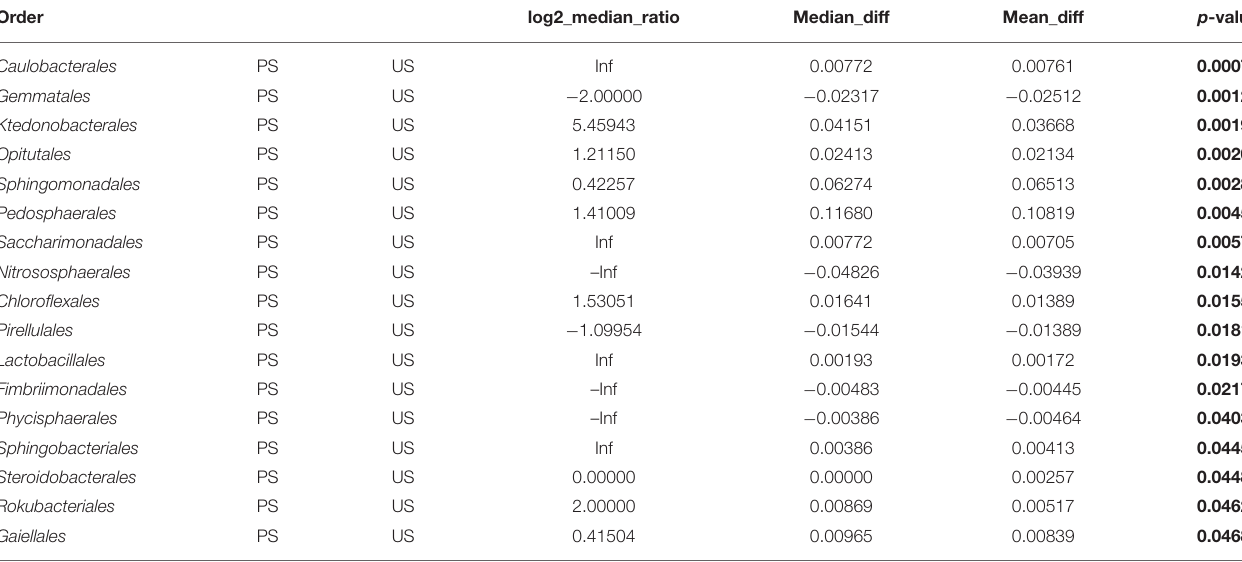
TABLE 3 | Outcomes of comparison of the bacterial composition of PS and US samples. Order log2_median_ratio p -value